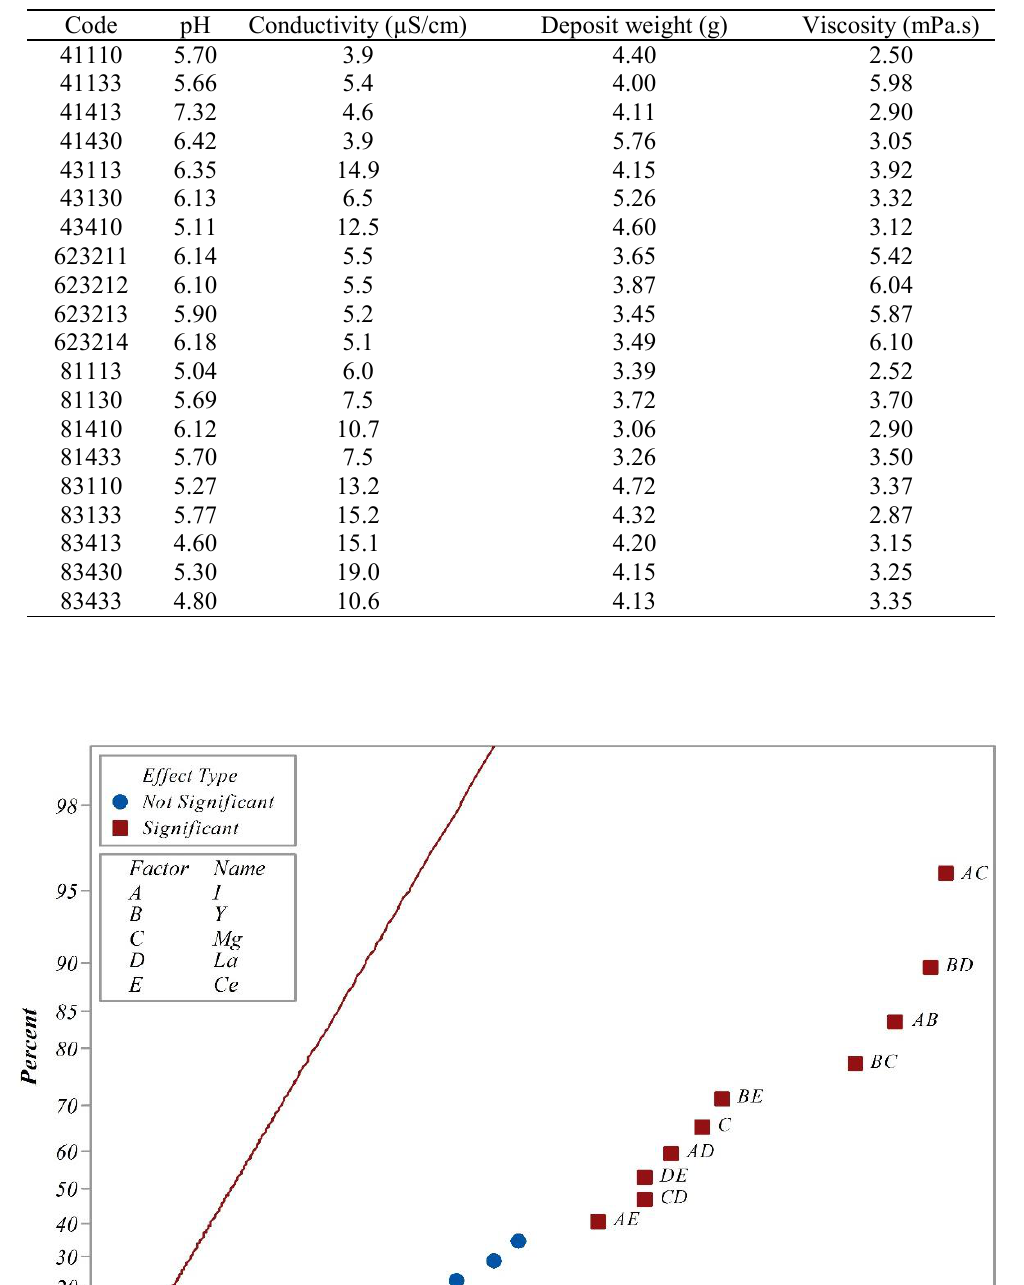
Table 4. Experimental results (according to sample code order)